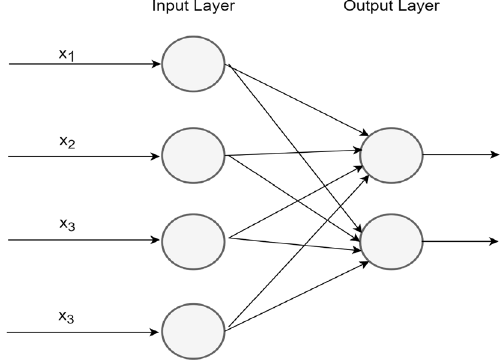
Fig. 4 Single layer perception. Source : [6]